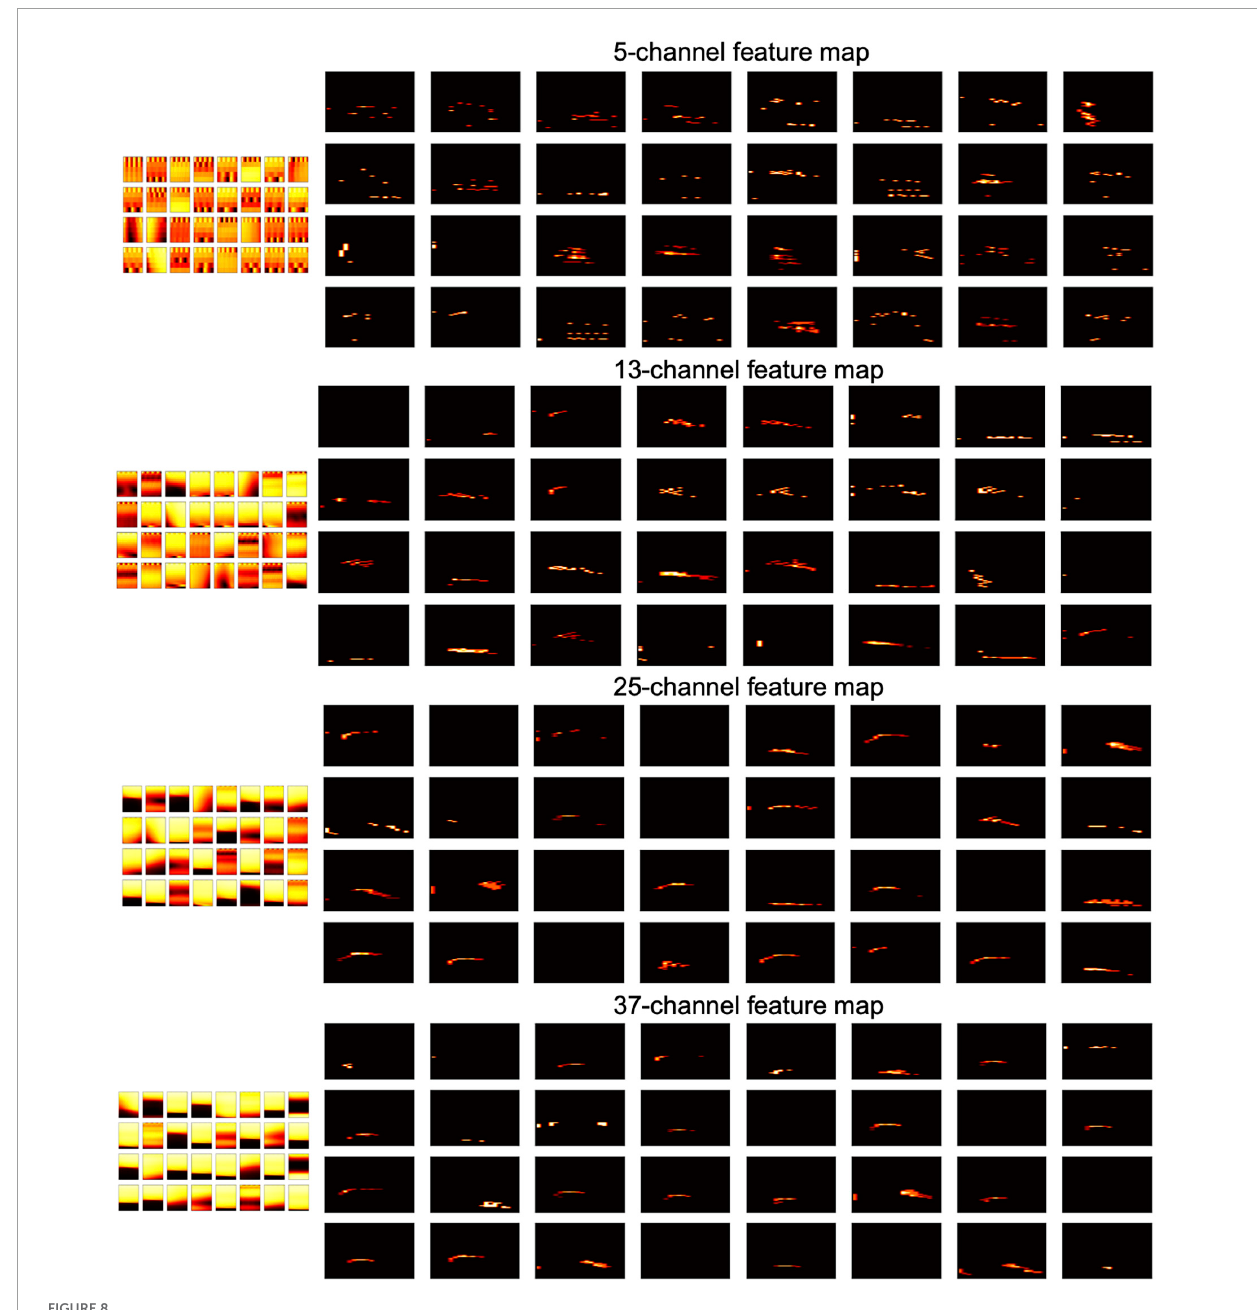
FIGURE8 The 32 2-D neurons and down-sampled feature